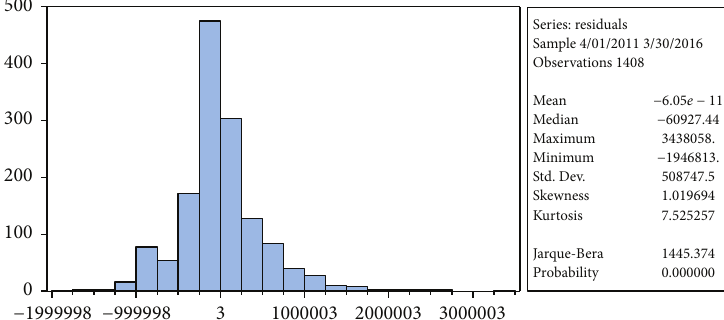
Figure 6: Histogram of residuals after fitting intervention ARIMA model.